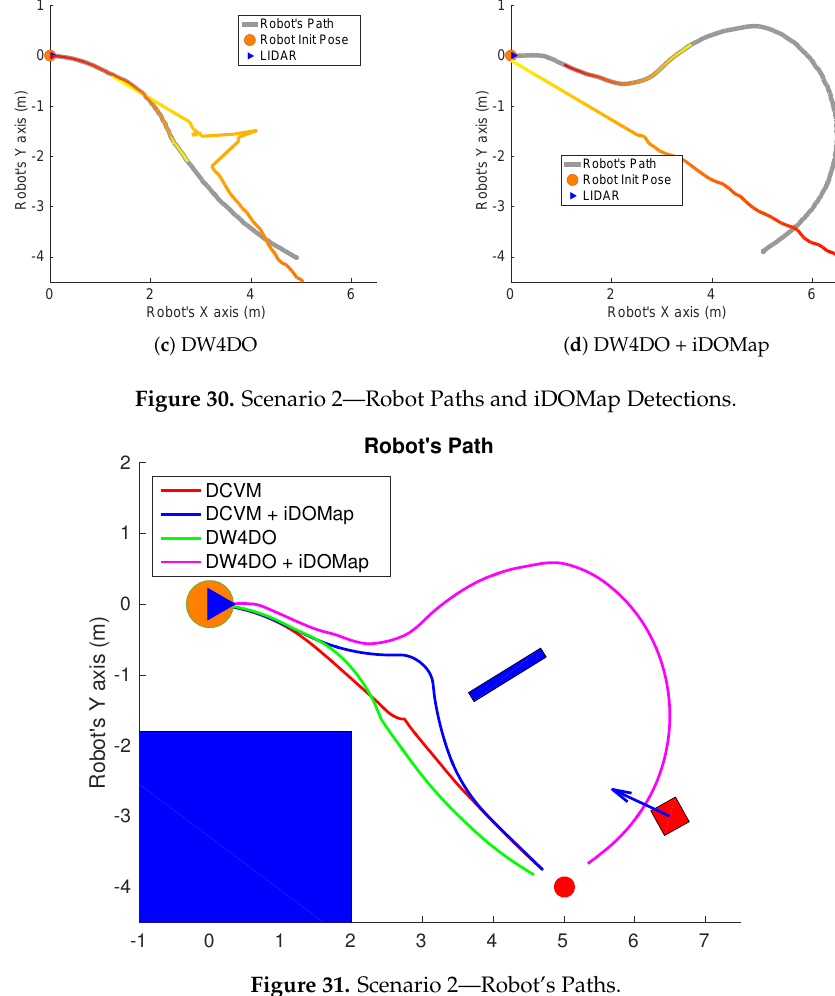
Figure 31. Scenario 2—Robot’s